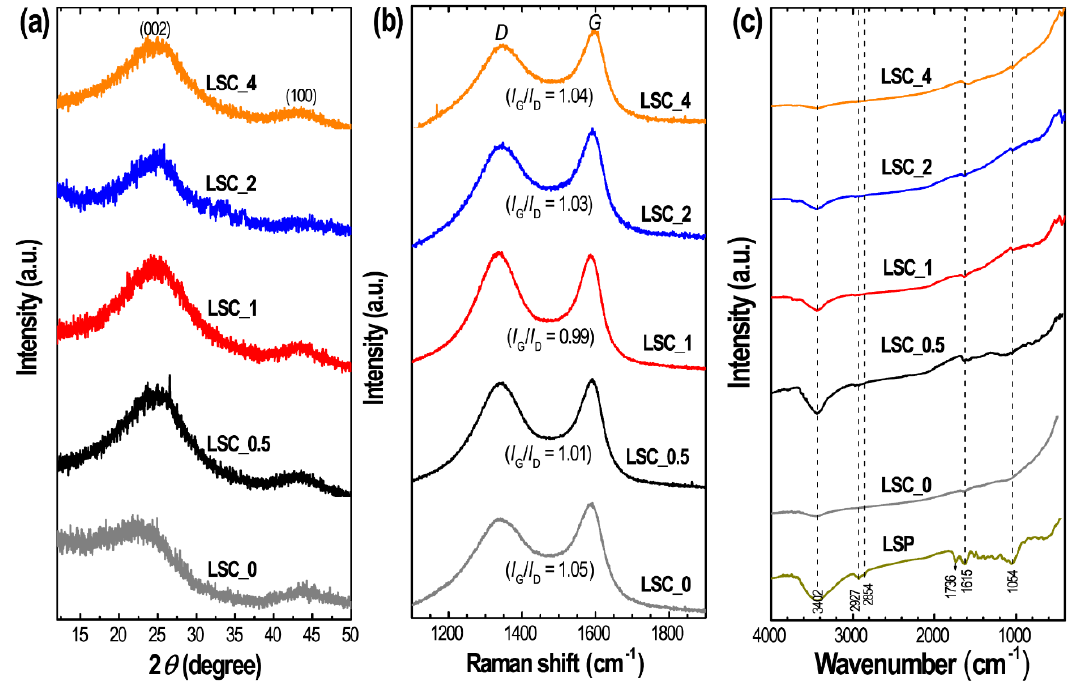
Figure 1. ( a ) Powder X-ray diffraction (XRD) patterns, ( b ) Raman scattering spectra and ( c ) Fourier transform infrared (FTIR) spectra of LSC_0 , LSC_0.5 , LSC_1 , LSC_2 and LSC_4 . In panel ( c ), the FTIR spectrum of Lapsi seed powder (LSP) is also included.